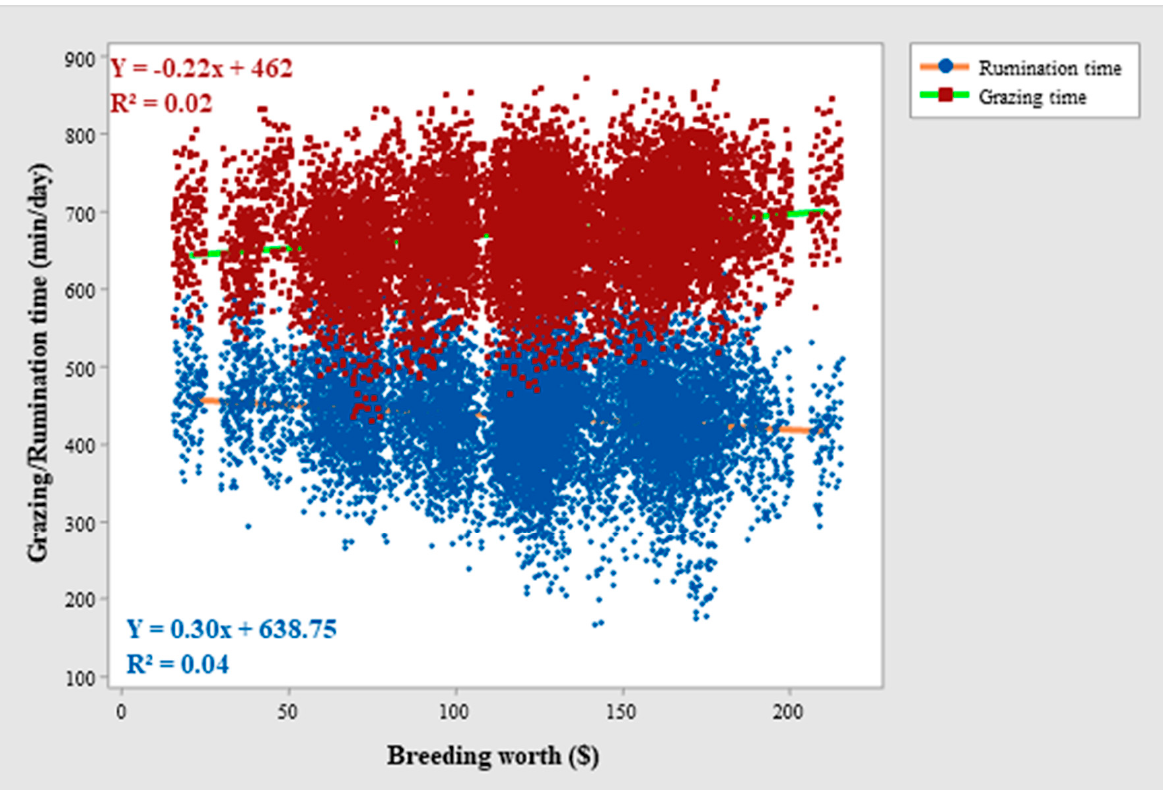
Figure 1. Scatterplot of grazing time (min/day) and rumination time (min/day) with breeding worth index value ($) of grazing dairy cows across the lactation period for Year-1 of the study period.